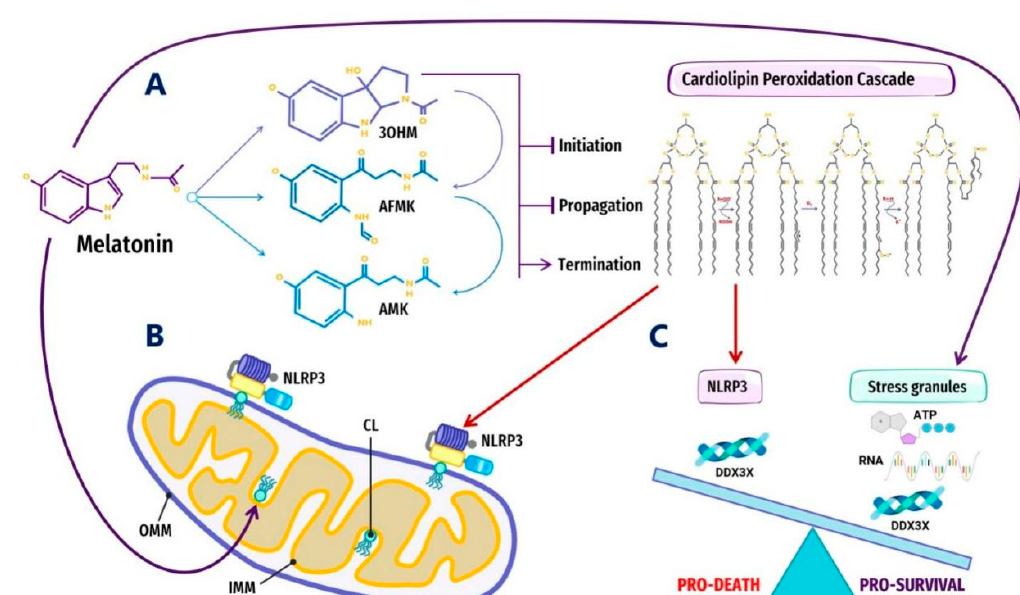
Figure 2. Overview of melatonin regulation of NLRP3 inflammasome (NLRP3) formation, assembly and activation: ( A ) Summary of melatonin and metabolite antioxidant cascade inhibiting the initiation and propagation of cardiolipin (CL) peroxidation, effectively terminating the CL peroxidation cascade; ( B ) Oxidized CL is externalized from the cristae/inner mitochondrial membrane (IMM) to the outer mitochondrial membrane (OMM) where it docks and primes NLRP3 inflammasome assembly prior to activation in mitochondria; ( C ) DDX3X, an ATP-dependent DEAD-box RNA helicase, is the mediator that selects the formation of “Pro-Survival” stress granules or the transition of the NLRP3 inflammasome into “Pro-Death”, stable, prionoid-like complexes. The successful formation of stress granules is also dependent upon the availability of ATP and RNA, both of which may be regulated by melatonin (See Abbreviations for additional acronyms).